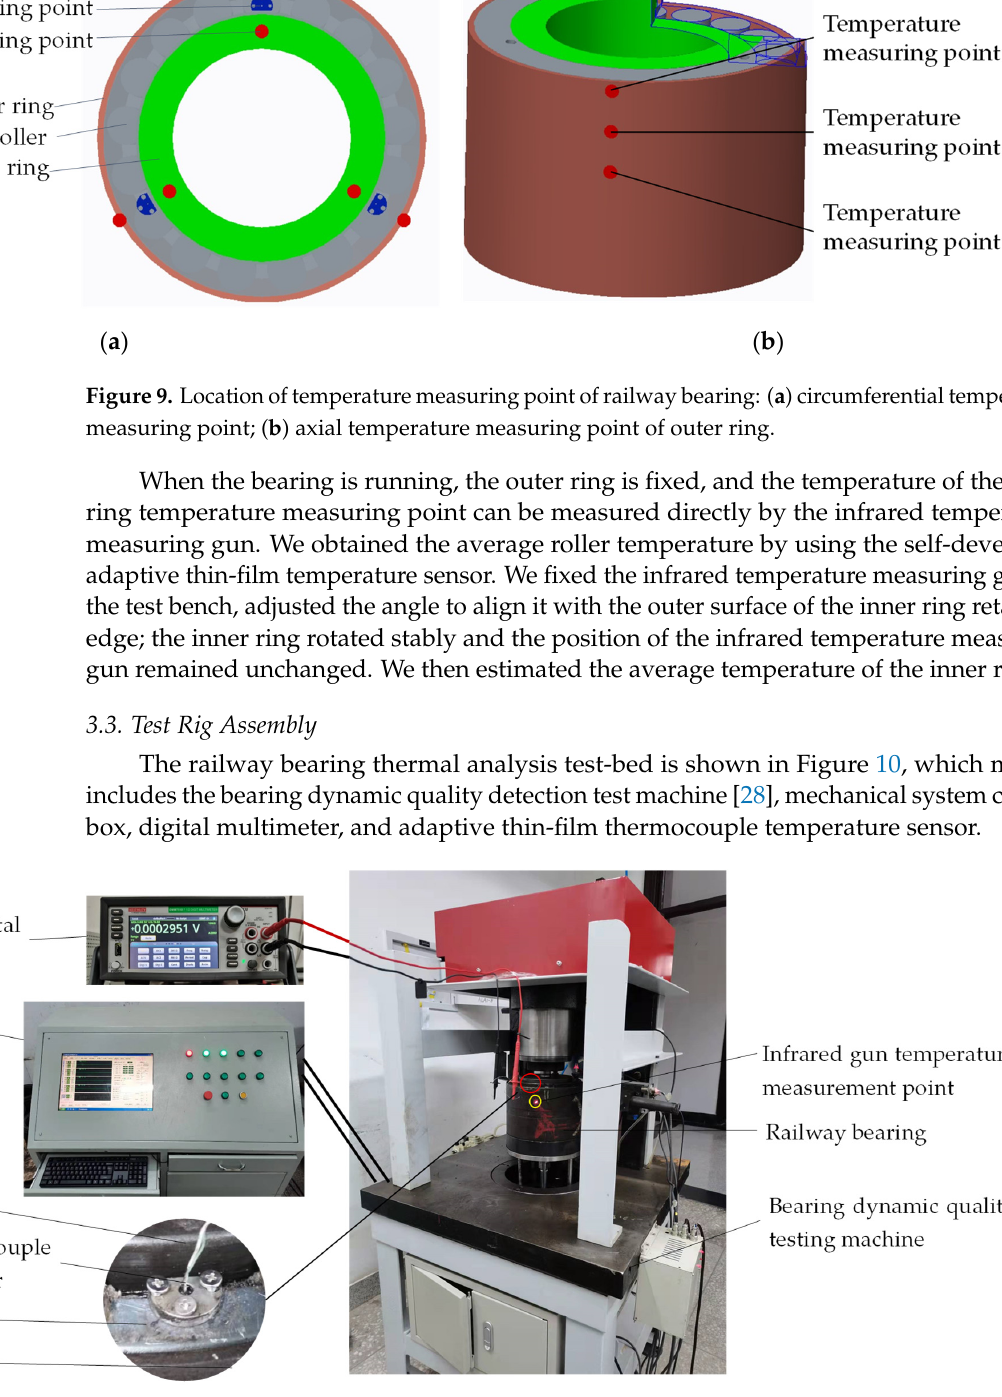
Figure 10. Railway bearing thermal analysis test bench.